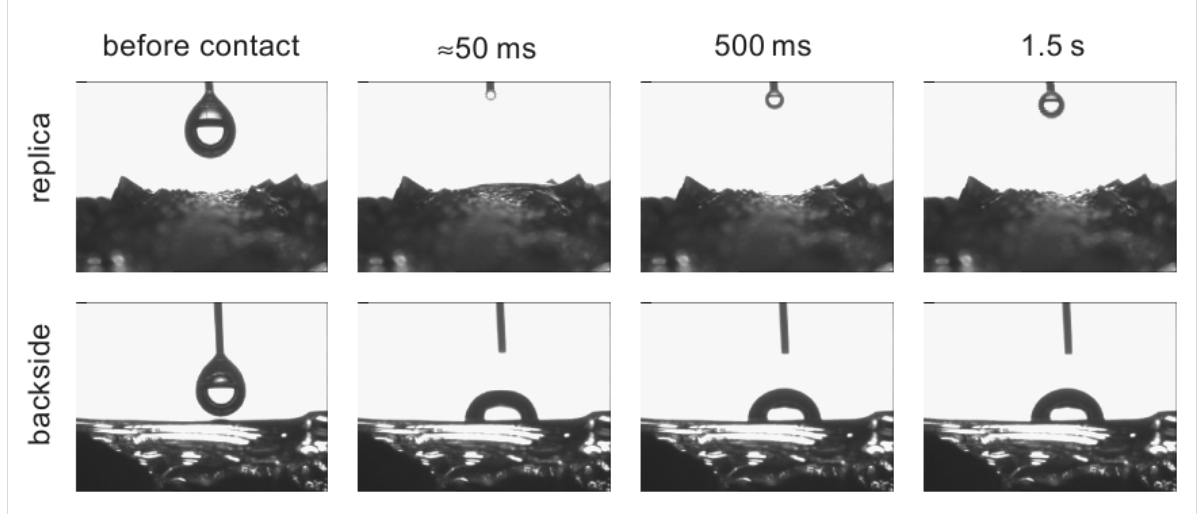
Figure 6: Water spreading on epoxy replica of moisture harvesting reptiles. A 5 µl droplet of water was applied to the epoxy replica of the medial back of the moisture harvesting species Phrynosoma cornutum . Similar to the situation on the native surface (see Figure 3), the water spreads at high velocity. The epoxy resin is not very wettable as can be seen when a 5 µl droplet is applied to the backside of the replica which exhibits an unstruc- tured surface. The droplet stays perfectly constant forming a contact angle of about